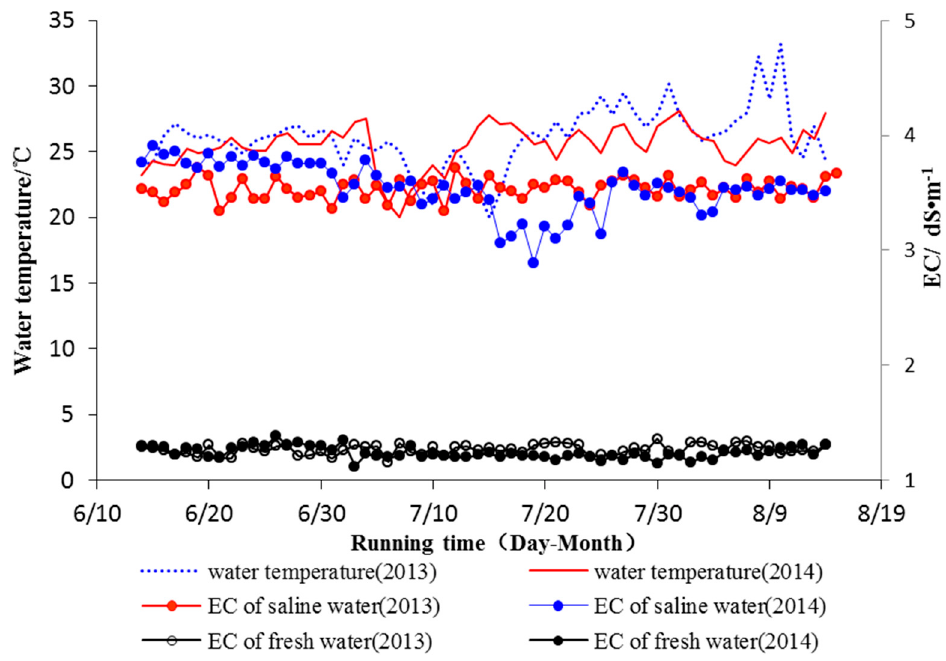
Figure 2. Variation in water temperature and electrical conductivity (EC) during the experiment.